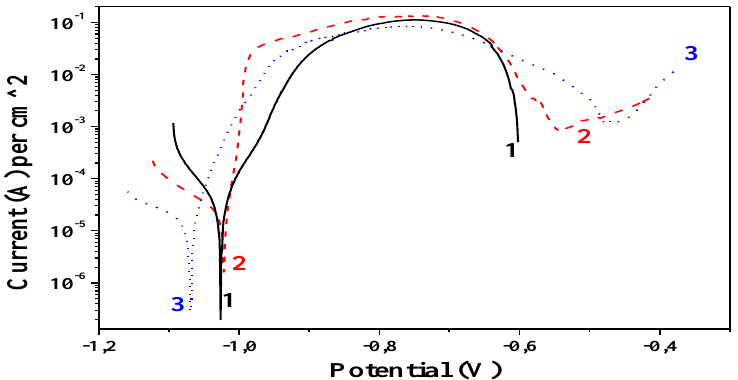
Figure 5. PD curves of ordinary Zn and both hybrid coatings: 1—Zn; 2—Zn-PANI / PVP; 3—Zn-PANI / SiO 2 .